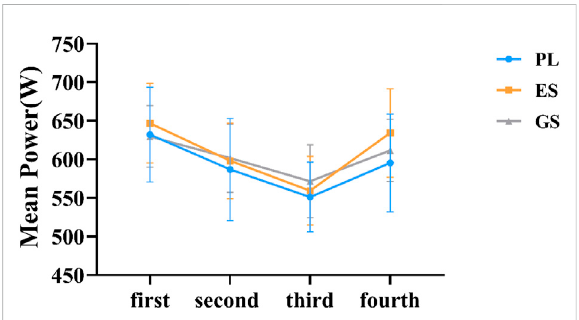
FIGURE 2 Trend of mean power. The horizontal coordinate represents the order of WACT in the experiment. The fi gure represents the mean ± SD of mean power data for three conditions.